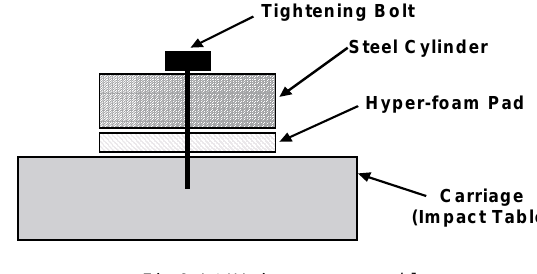
Fig. 2. LANL impact test assembly.